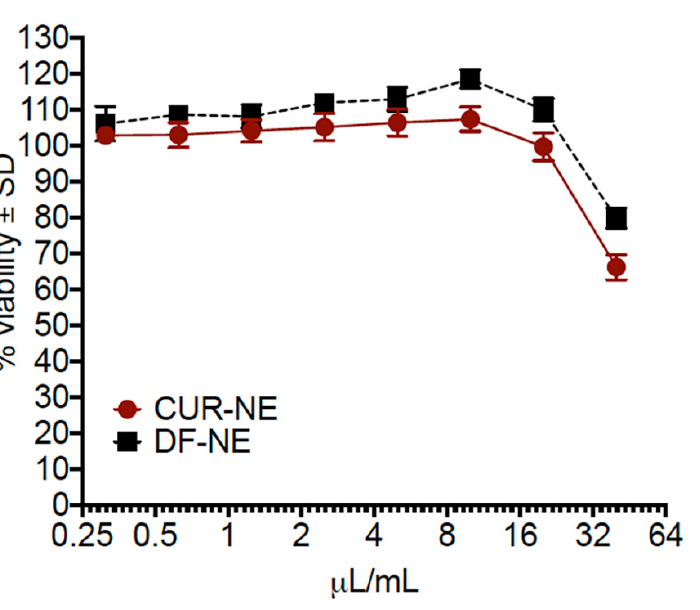
Figure 8. Viability of RAW 264.7 cells in the presence of CUR-loaded nanoemulsions. Nanoemulsions were diluted into the complete medium to achieve the desired nanoemulsion concentrations.